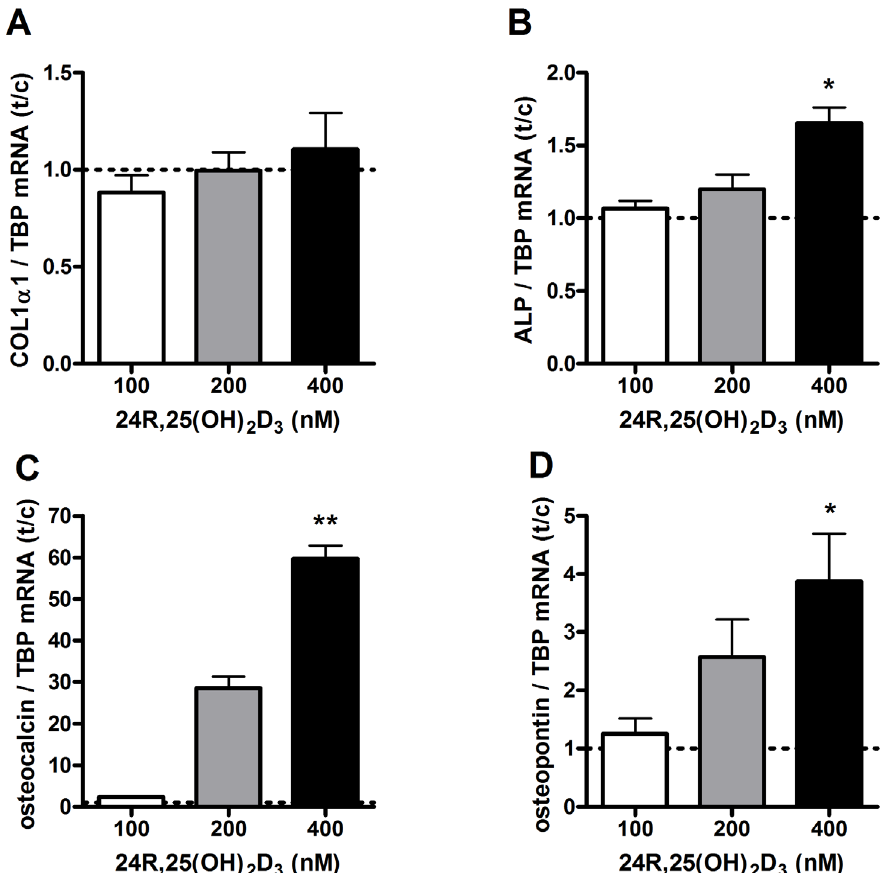
Figure 7. Effects of 24R,25(OH) 2 D 3 on mRNA levels of genes involved in osteoblast differentiation. Osteoblasts were cultured in the presence of 0, 100, 200 or 400 nM 24R,25(OH) 2 D 3 and mRNA levels of COL1 a 1 ( A ), ALP ( B ), osteocalcin ( C ) and osteopontin ( D ) were determined after 72 hours. Results (mean 6 SEM) are expressed as treatment versus control ratios (control was set at 1.0; dashed line) using cells from 4 different donors. Results were analysed using Friedman test followed by Dunn’s post hoc test (*p , 0.05, **p , 0.01, ***p , 0.001).